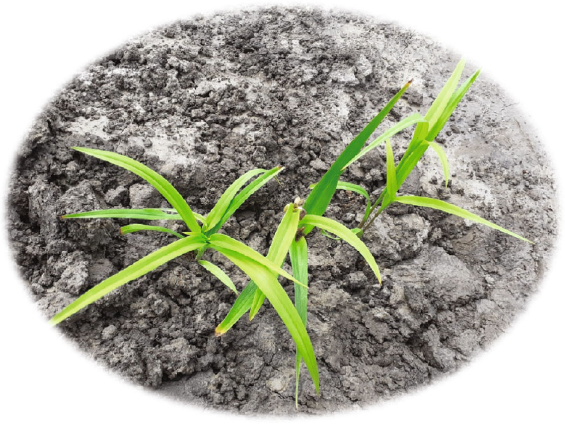
Figure 1: Commelina communis grown in a